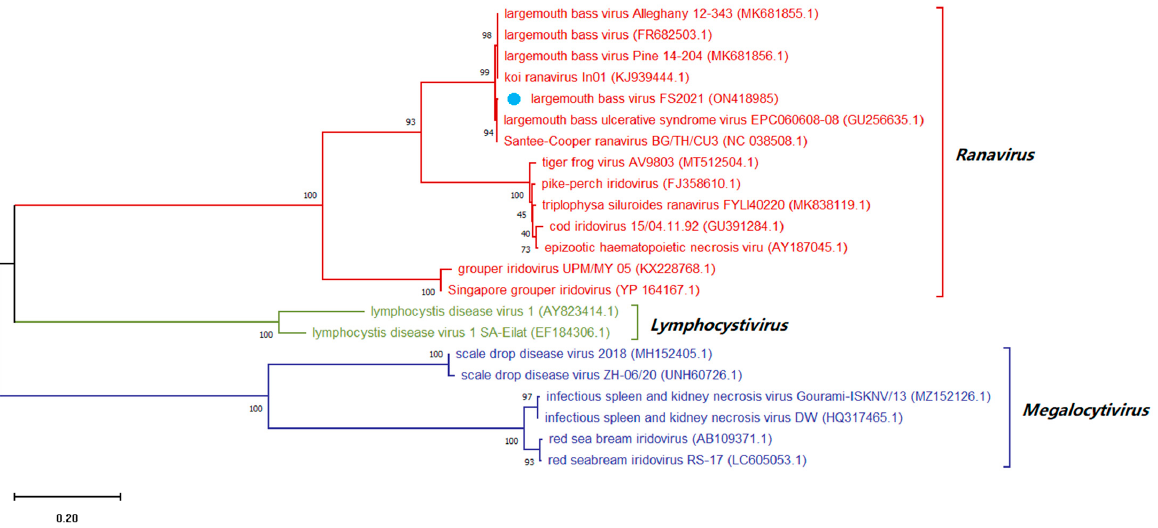
Figure 7. Maximum-likelihood tree of the major capsid protein (MCP protein) gene sequence of LMBV-FS2021. LMBV-FS2021 is designated by the blue dot. GenBank accession numbers are shown in brackets. The evolutionary history was inferred by using the Maximum Likelihood method and Kimura 2-parameter model. The tree with the highest log likelihood ( − 10532.26) is shown. The percentage of trees in which the associated taxa clustered together is shown next to the